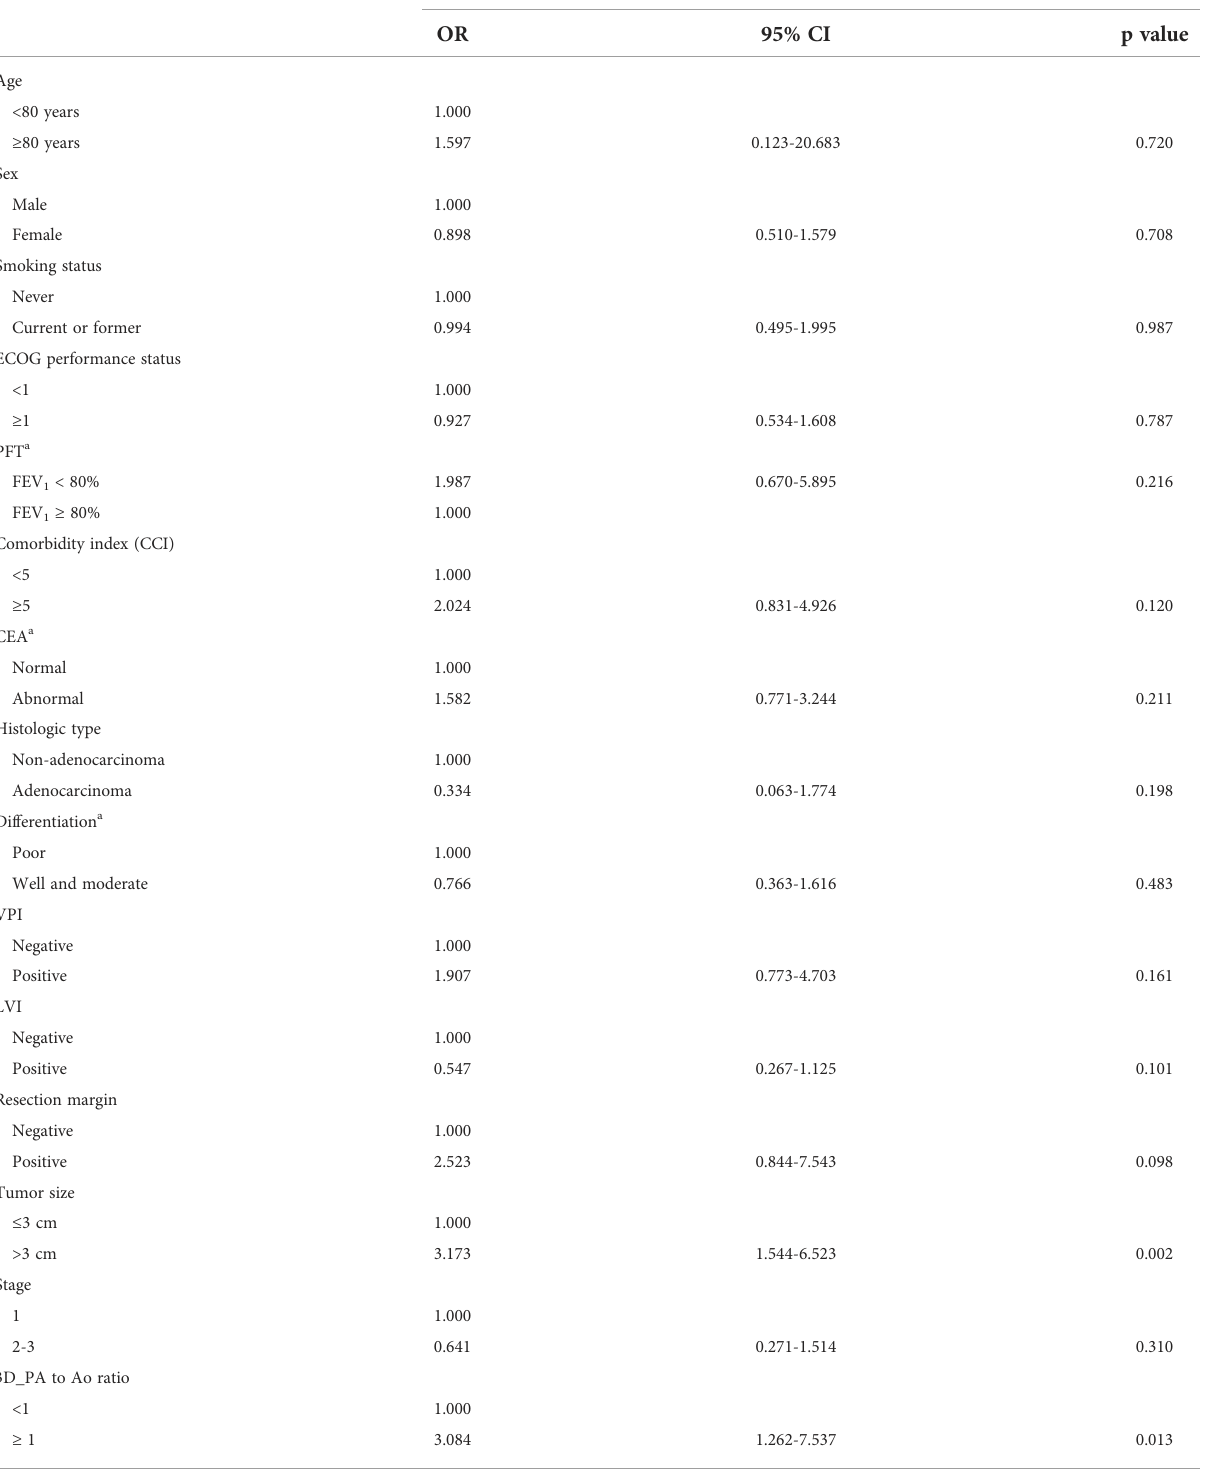
TABLE 5 Multivariate analysis between clinicopathologic features and postoperative complications (all grade) in this